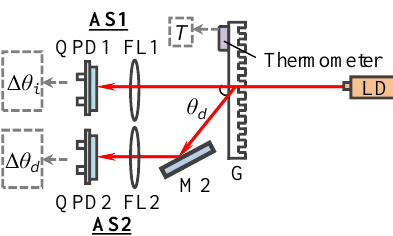
Figure 3. Principle of the real-time wavelength corrector (RWC).